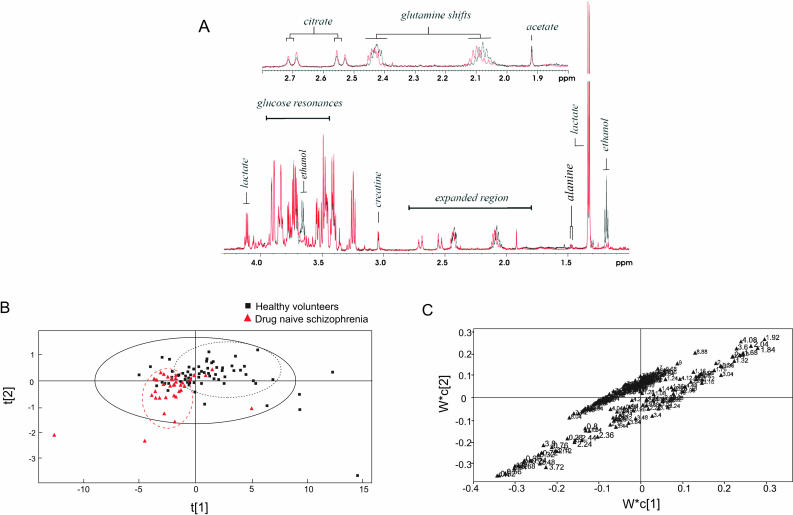
Metabonomic Analysis of CSF Samples from Drug-Naïve Patients with Schizophrenia(A) Partial 1H NMR spectrum of a CSF sample from a representative drug-naïve patient with first-onset schizophrenia (red) and a matched control (black) illustrate a characteristic pH-dependent shift in the β-CH2 and γ-CH2 resonances of glutamine. The prominent signals at ~3.7 and 1.2 ppm correspond to ethanol, a contaminant from skin disinfection prior to lumbar puncture. These signals were removed from statistical analysis.(B) PLS-DA scores plot showing a differentiation of drug-naïve patients with schizophrenia from demographically matched controls as determined by the 1H NMR CSF spectra.(C) PLS-DA loadings plot showing major contributing variables towards the separation in the PLS-DA scores plots.